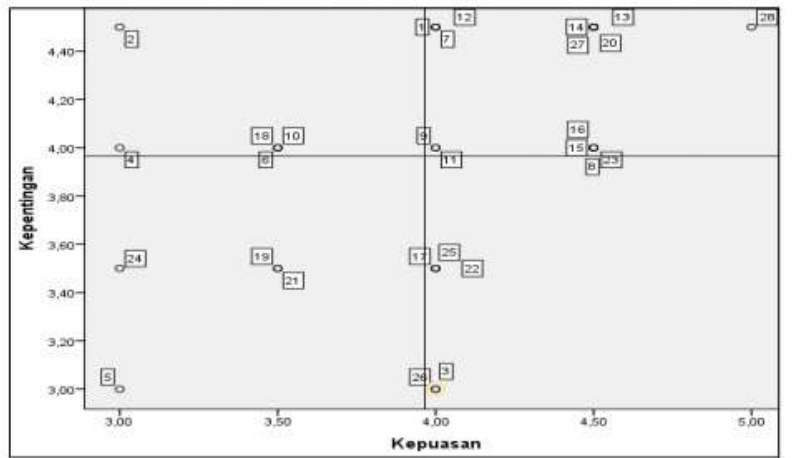
Figure 7. Importance Performance Analysis Results Belitung Source: Processed,